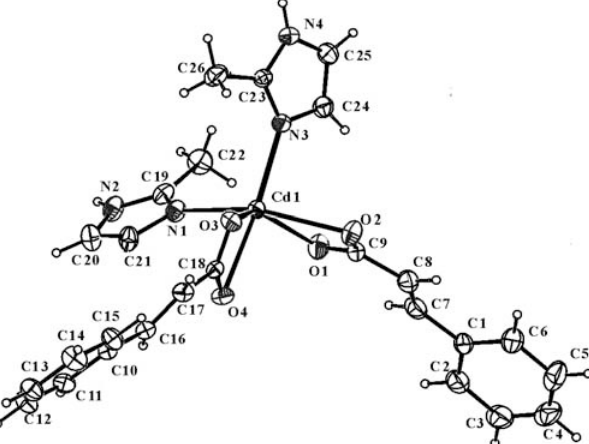
Table 1. Data collection and handling.